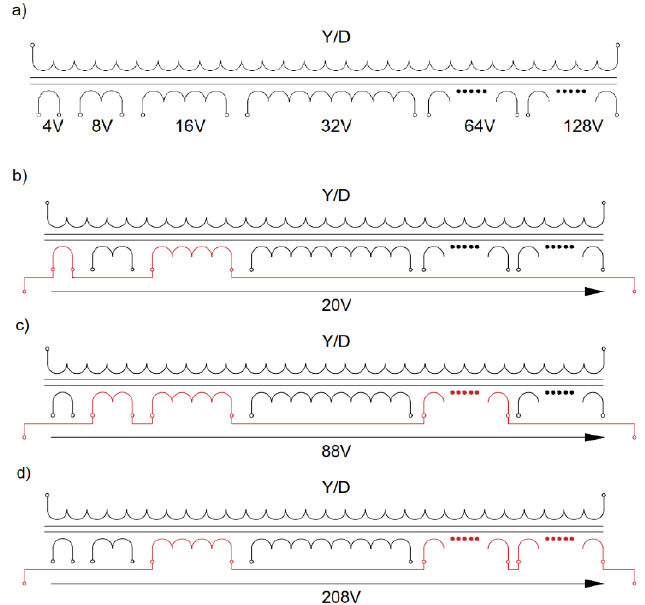
Figure 7. Some possible connections of the ST secondary windings in a single-phase equivalent: ( a